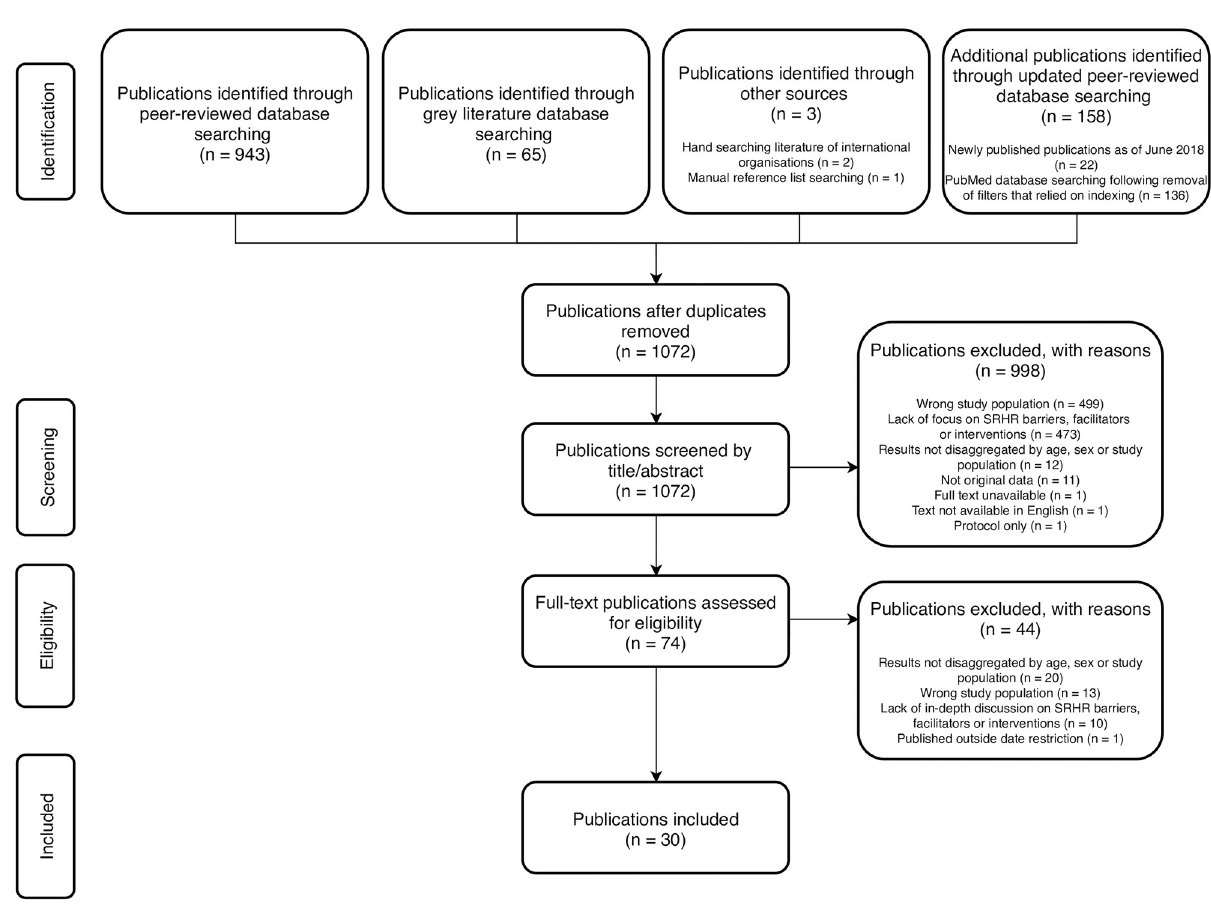
Fig 1. PRISMA flow diagram of the scoping review